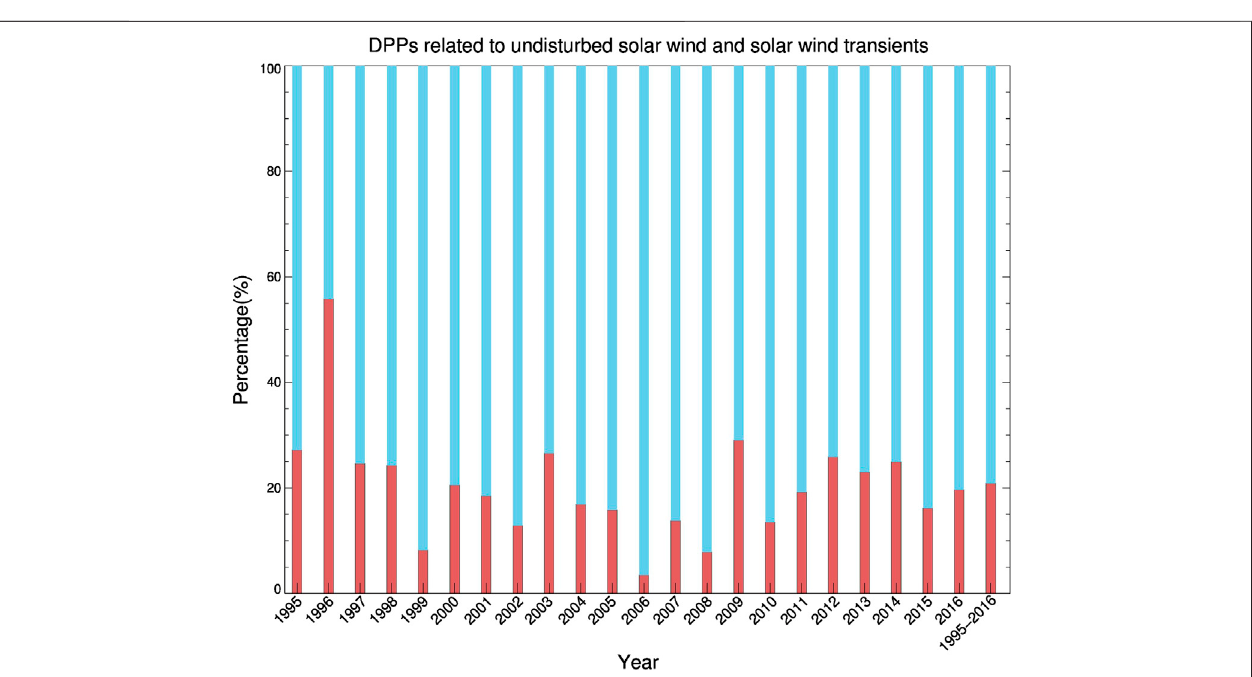
FIGURE 2 | Proportion of DPPs associated with the undisturbed solar wind (indian red) and solar wind transients (sky blue).